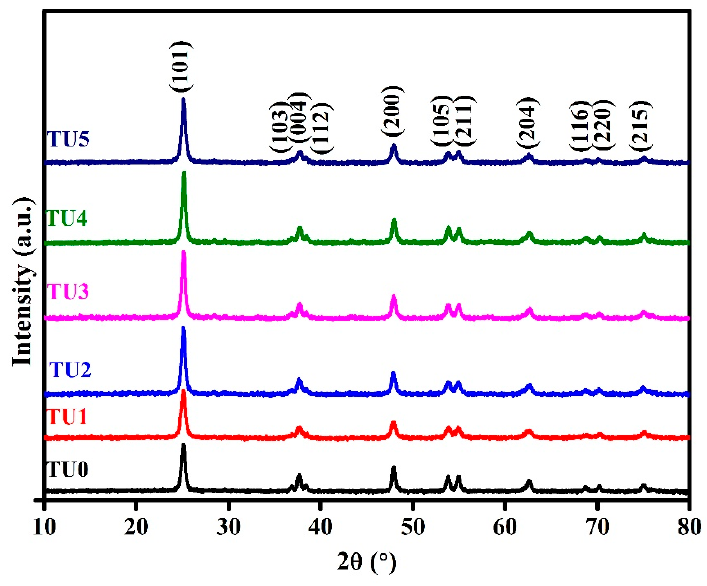
Figure 1: RD patterns of TU0, TU1, TU2, TU3, TU4 and TU5. Figure 1. RD patterns of TU0, TU1, TU2, TU3, TU4 and